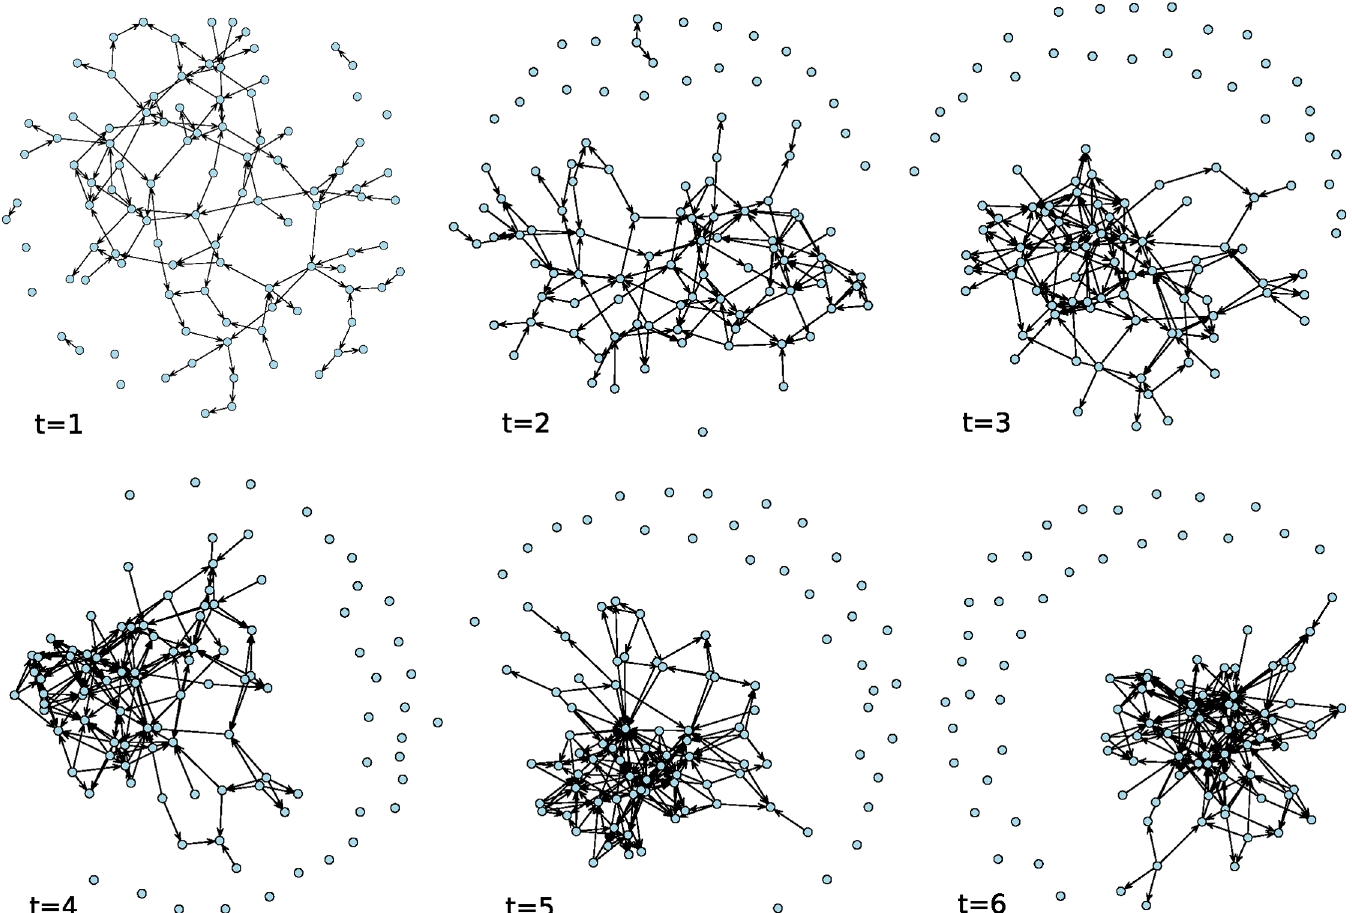
Fig 1. Evolution of social influence on a Bernoulli random graph with n = 100 nodes and tie probability equal to 1/ n . Patterns of influence among individuals (nodes) over time represented as networks in which a tie denotes the presence and direction of social influence between two individuals at a particular time.